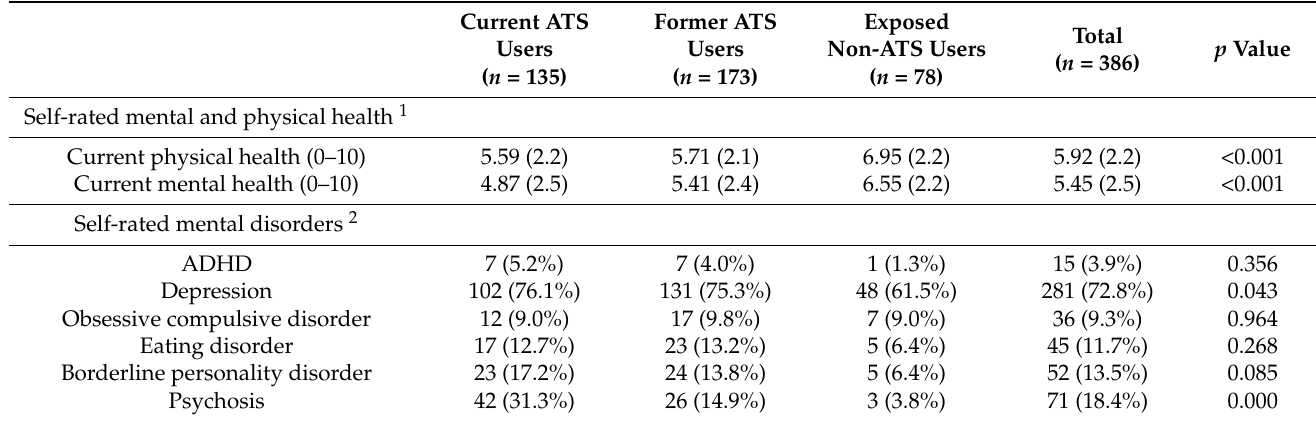
Table 4. Self-rated mental and physical health and self-reported lifetime prevalence of mental disorders by study group.